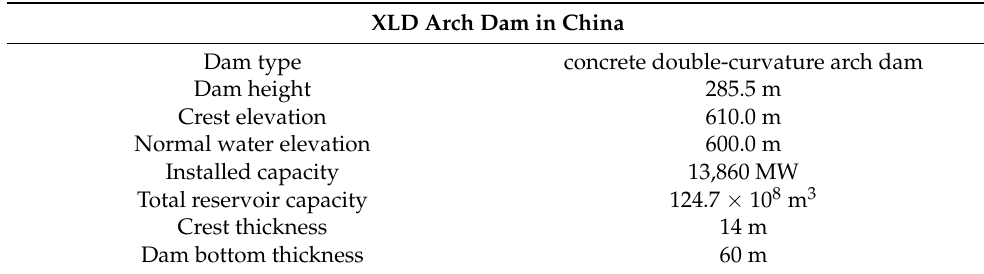
Table 1. General characteristics of XLD concrete arch